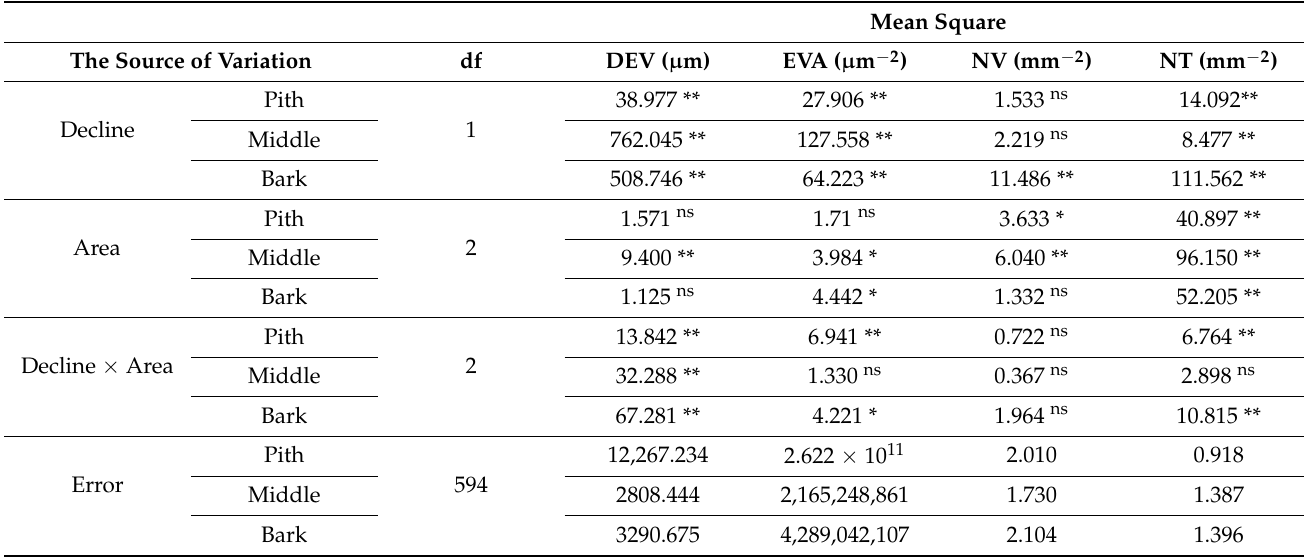
Table 4. One-way ANOVA of wood-anatomical variables between healthy trees and those with decline at the three study areas.